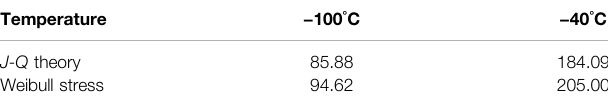
(cid:18)(cid:18) √ m